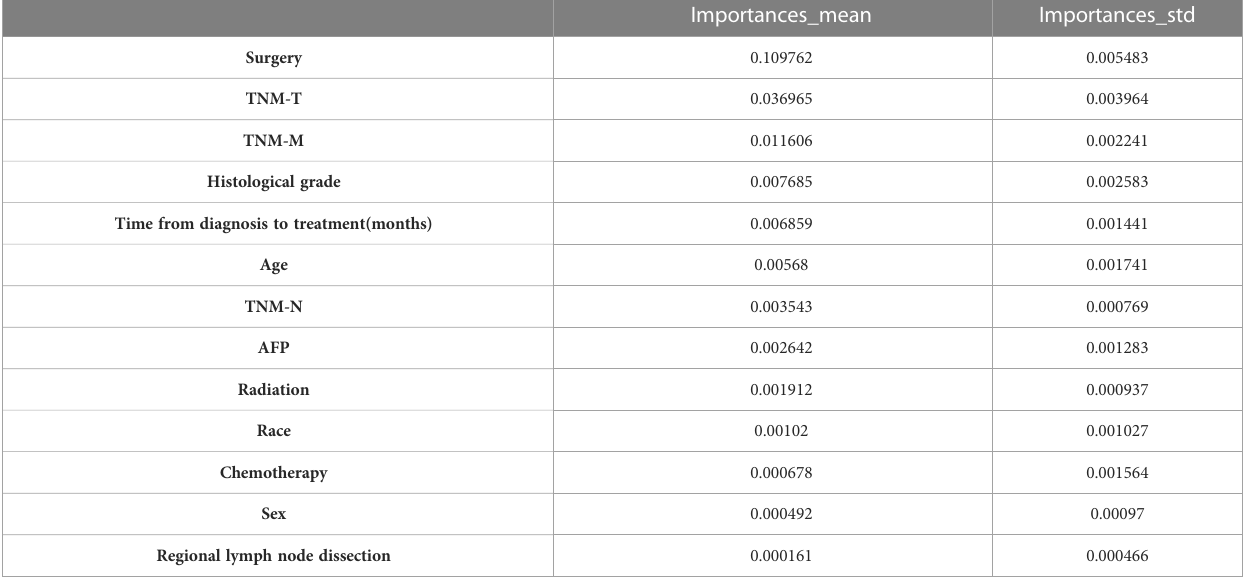
TABLE 4 Clinical feature